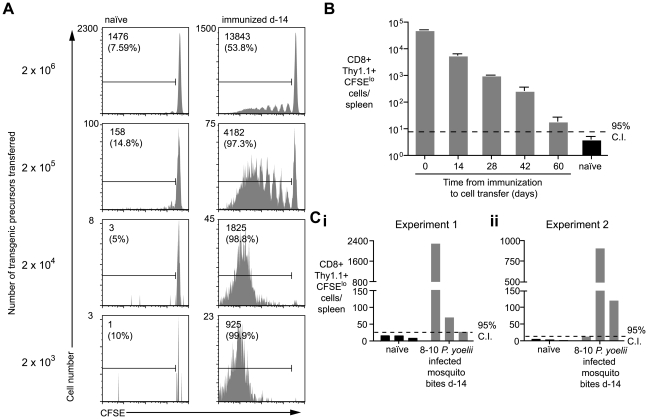
Duration of antigen presentation, and antigen persistence after mosquito biting.A. Mice were immunized with 5×104 irradiated sporozoites i.v. and 14 days later 2×103–2×106 CFSE labeled transgenic cells were transferred to the mice and to unimmunized controls. Ten days later transgenic cells were enriched from the spleen and their CFSE profile determined by FACs. Representative plots from one of three mice per group are shown. Values given are the total number of divided transgenic (CD8+ Thy1.1+ CFSElo) cells isolated from the spleen and in parentheses the % of total recovered transgenic cells that have divided (data representative of numerous similar experiments). B. Mice were immunized as in A. and 1×104 transgenic cells were transferred to mice at different time points after immunization. Ten days after transfer the cells were recovered and the number of divided transgenic cells recovered was determined (n = 3, mean ± SE; data representative of two similar experiments). C. Three mice were bitten by 8–10 infected P. yoelii infected mosquitoes. Fourteen days later 1×104 transgenic cells were transferred to the mice and 10 days later the number of divided transgenic cells was determined. Bars represent values for individual mice; data shown from two independent experiments (i and ii).